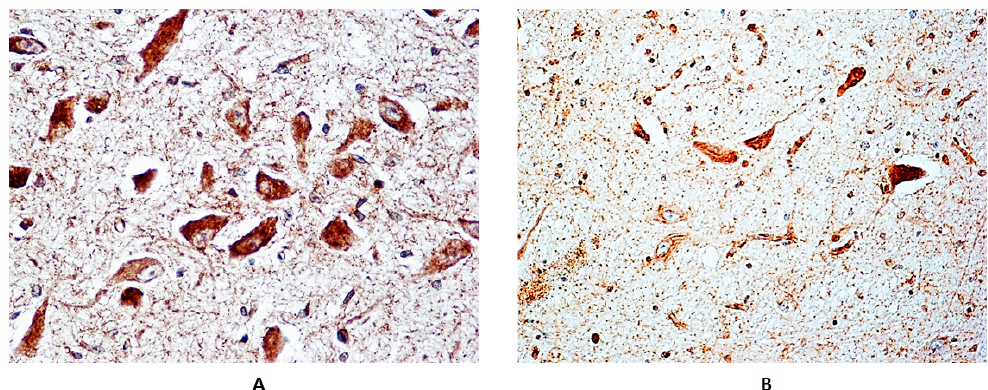
Figure 4. Strong α 7-nAChR immunopositivity (“Class 3” of α 7-nAChR-Index) in the Kölliker-Fuse nucleus (KFN). ( A ) Normal structure and ( B ) hypoplasia of the KFN in two e-SIDS cases (both died in the first postnatal week). ( A , B ) α 7-nAChR immunostaining; magnification: 100 × .